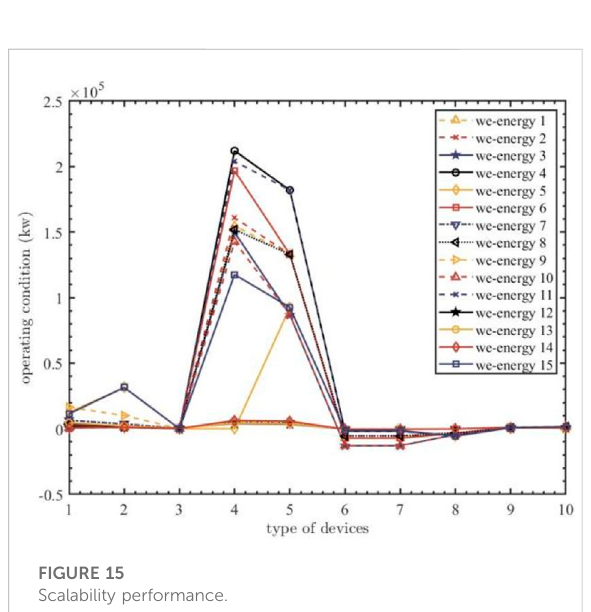
FIGURE 15 Scalability